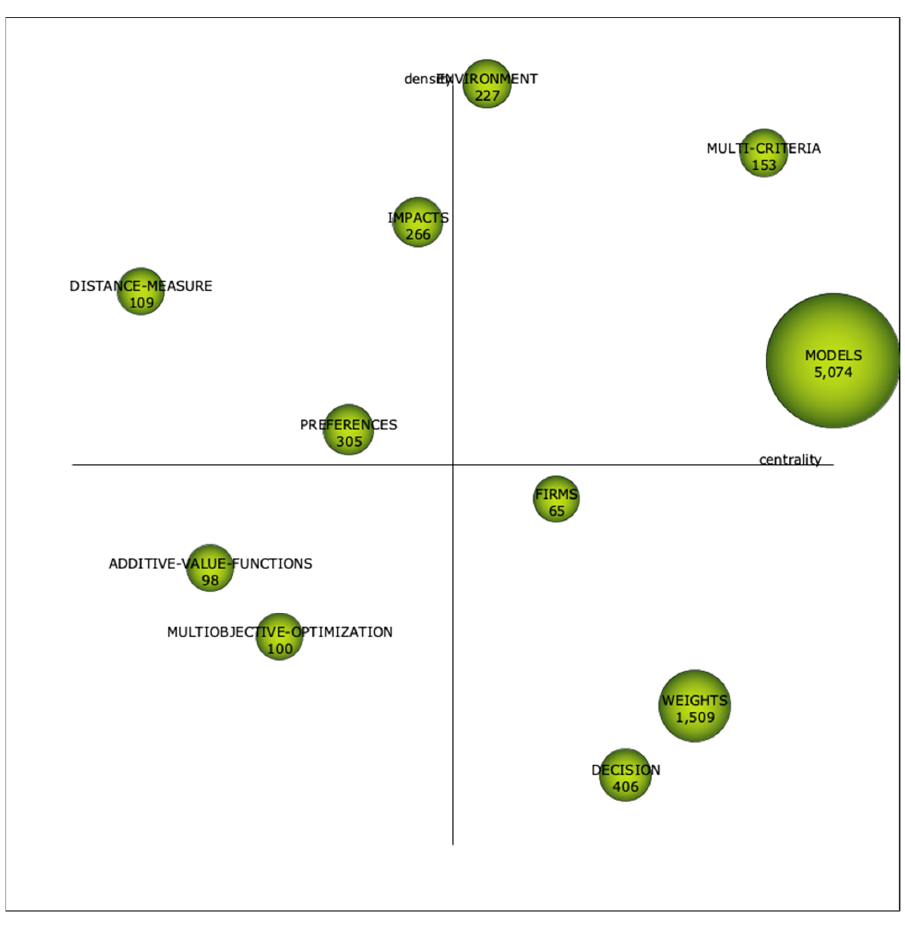
Figure 9. Strategic diagram of subperiod 2 (2009–2022). Table 6. Clusters information. Subperiod 2